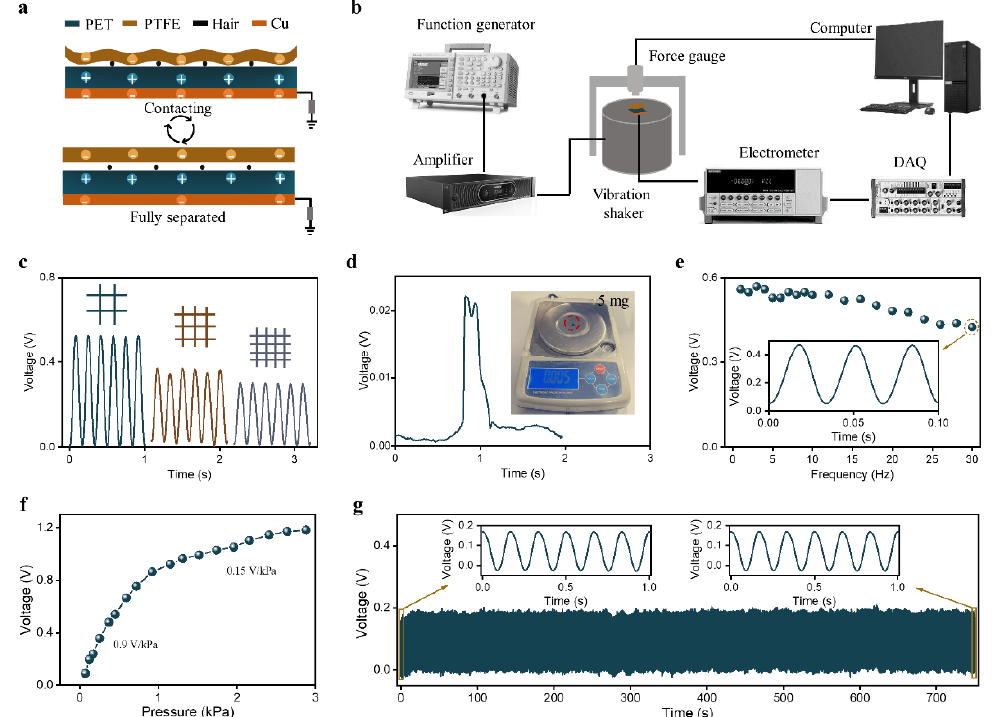
Figure 2. Electrical output and mechanical robustness measurements of HBPS: ( a ) working mecha- nism of HBPS, ( b ) self-designed testing system for acquiring a quantitative understanding of the electrical output performance of HBPS, ( c ) the output voltage of the HBPS composed of hair with different distance (3.2 mm, 2.4 mm, 1.9 mm), ( d ) output voltage of the HBPS under the pressure of a plastic sheet with 5 mg weight, ( e ) output voltage of the HBPS under a pressure of 0.45 kPa at frequencies ranging from 1–30 Hz, ( f ) pressure sensitivity of the HBPS, and ( g ) output stability of the HBPS.